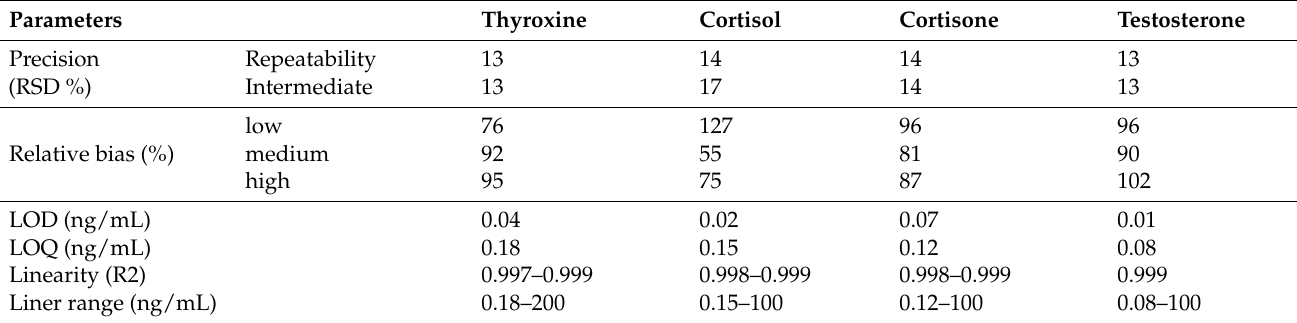
Table 2. Precision is expressed by the relative standard deviation (RSD %), relative bias (%), the limit of detection (LOD), the limit of quantification (LOQ), linearity, and linear